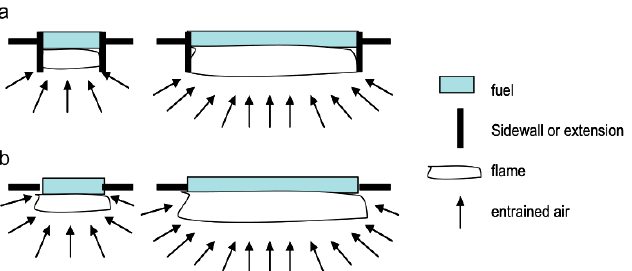
Figure 22. Planform of air entrainment variations under varying widths with ( a ) or without ( b ) sides [32].